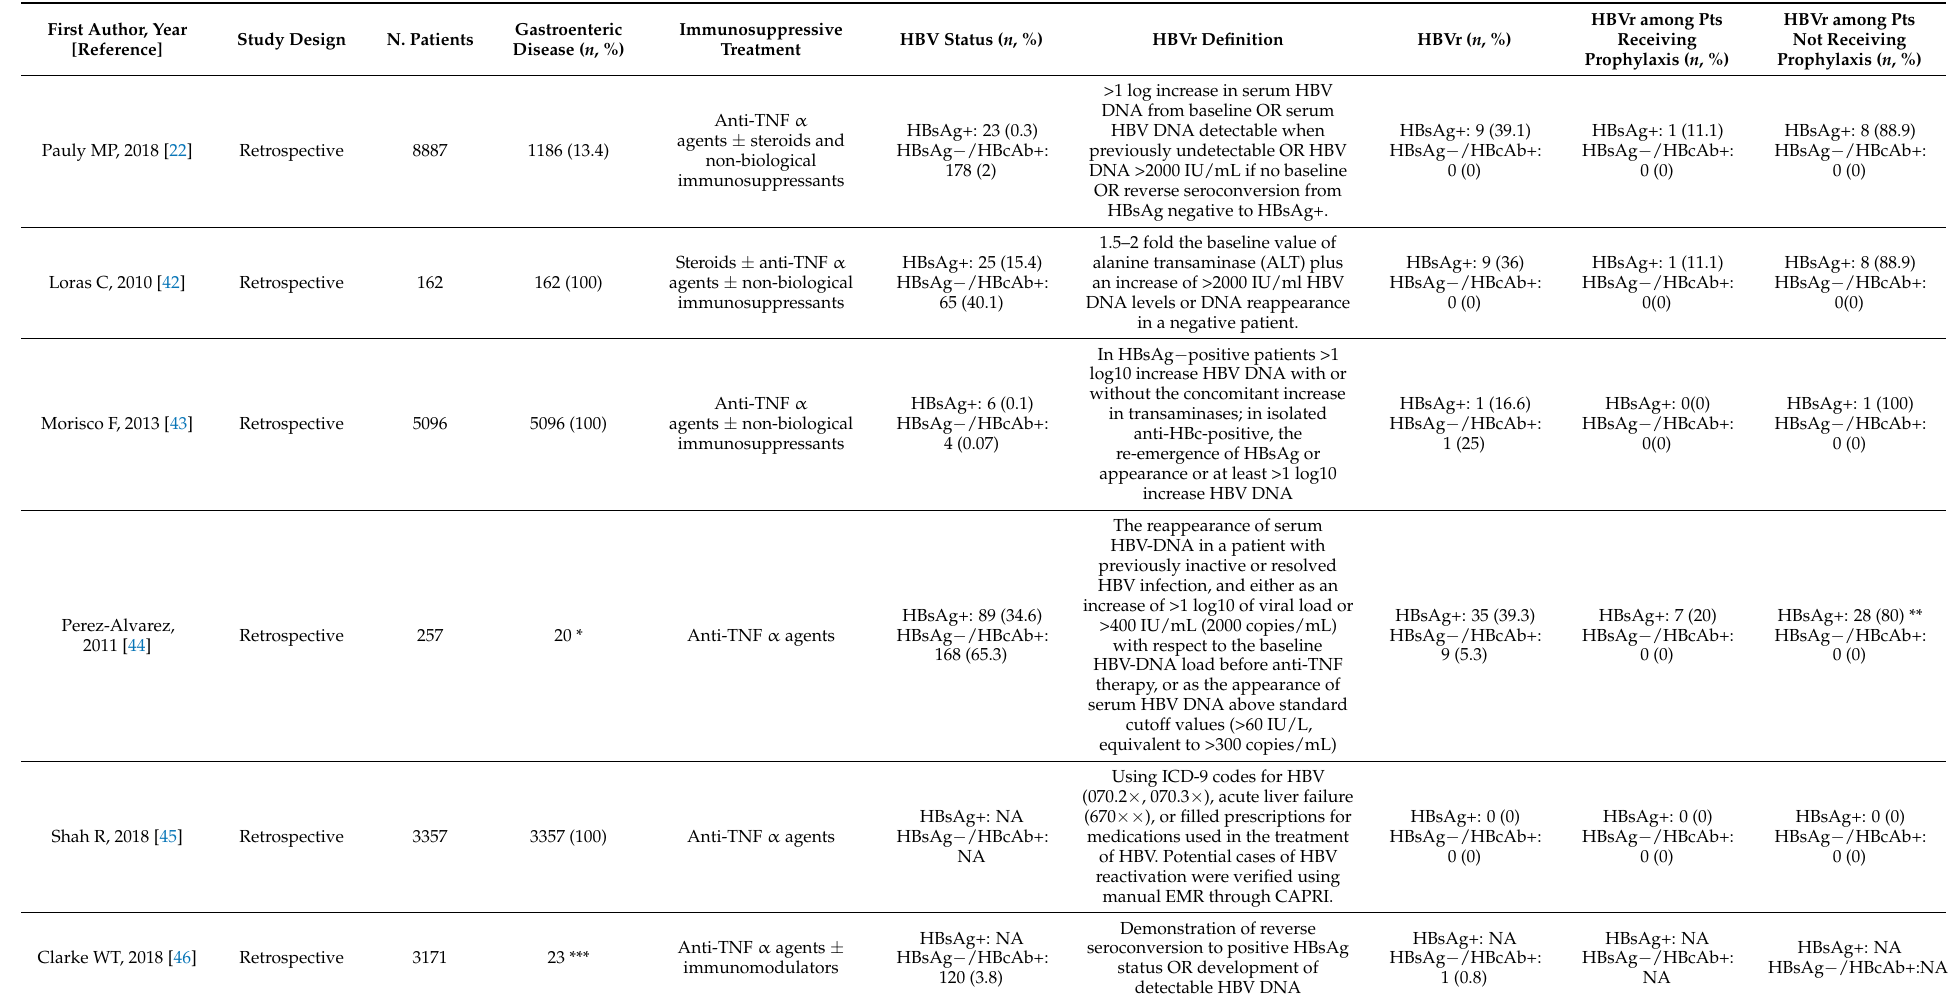
Table 1. Studies on HBV reactivation in patients with gastroenteric